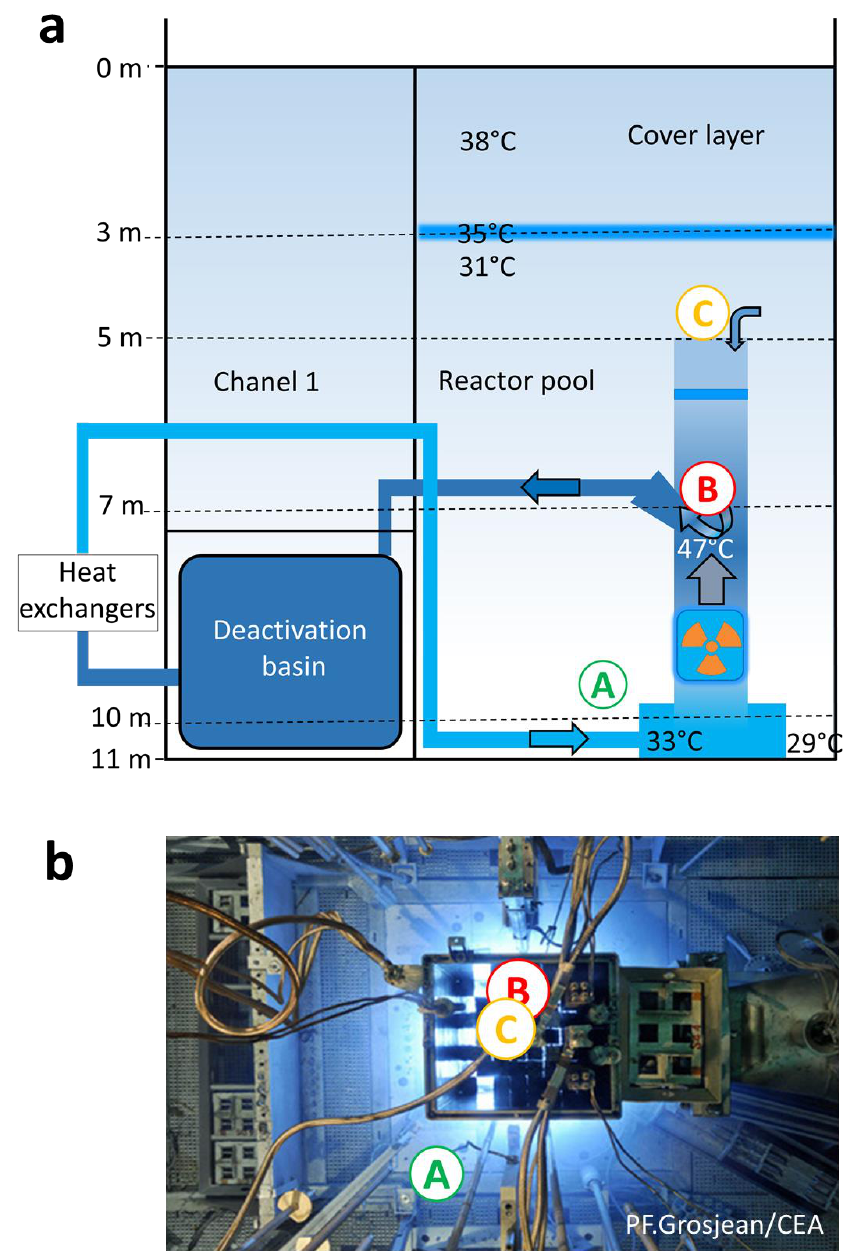
Figure 1. Configuration of the Osiris reactor’s pool (adapted from [11]) and sampling points A (pool’s bottom), B (inside the core unit), and C (above the core unit). ( a ) Schematic view, ( b ) top view. At shutdown, the radiation dose rate reached 25 Gy/h at point B, 15 µGy/h at point C, and was below 0.1 µGy/h at point A.